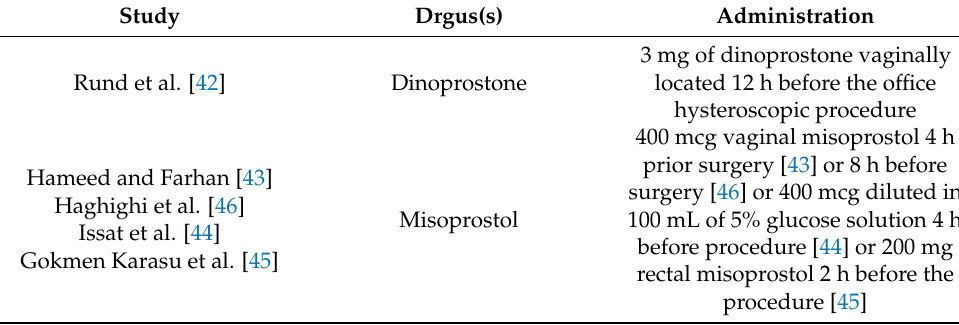
Table 1. Pharmacological strategies for pain relief in office hysteroscopy